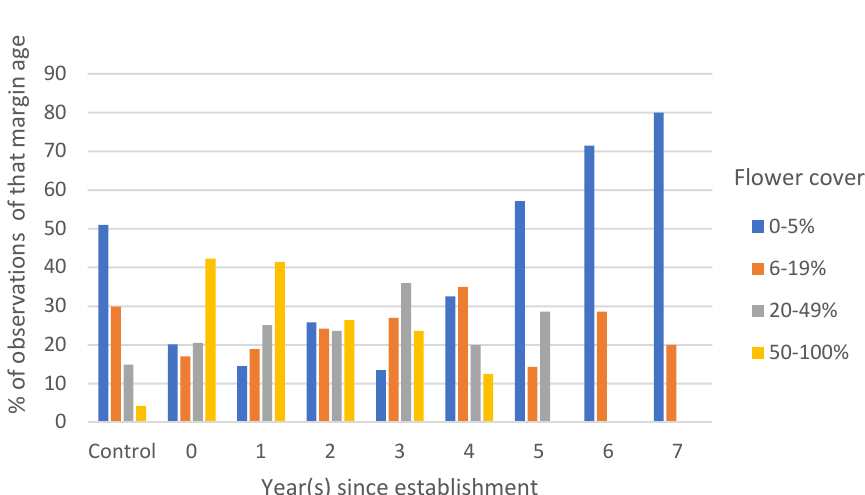
Figure A1. Flower abundance in the Operation Pollinator flower margins was scored as percent cover. The bar chart below shows the breakdown of flower abundance when observations of insect pollinators were conducted in margins of different ages (years since establishment) and also for the control margin.